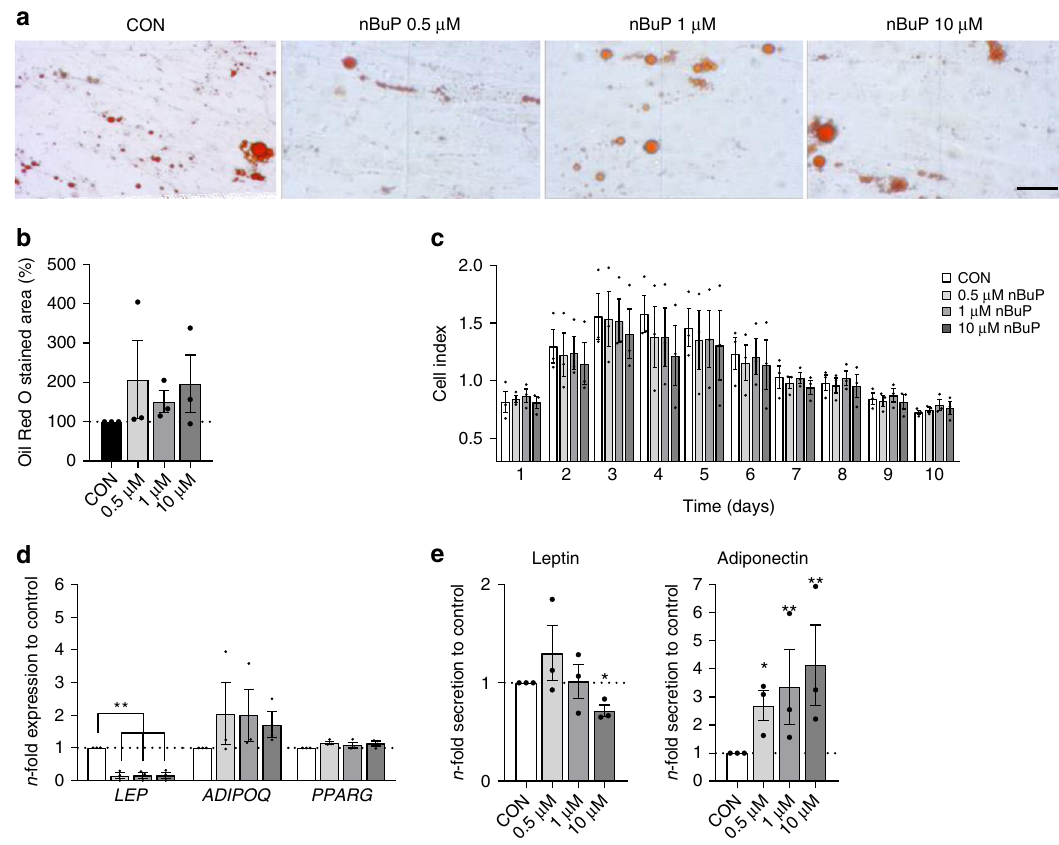
Fig. 1 Effect of nBuP exposure on adipocyte differentiation. In vitro adipocyte differentiation from human MSCs in the presence of nBuP. a Representative Oil Red O stained pictures after differentiation (scale bar: 100 µ m). b Triglyceride storage of adipocytes assessed via Oil Red O staining. c Real-time monitoring of cell differentiation (xCELLigence: normalised cell index) over a 17-day period. d Gene expression of leptin (LEP) , adiponectin (ADIPOQ) and the transcription factors peroxisome proliferator-activated receptor gamma (PPARG) . e Leptin and adiponectin levels in cell culture supernatant. Data are expressed as mean ± SEM of n = 3 experiments. Signi fi cant differences were derived by ANOVA with * P < 0.05 and ** P < 0.01. Source data are provided as a Source Data fi